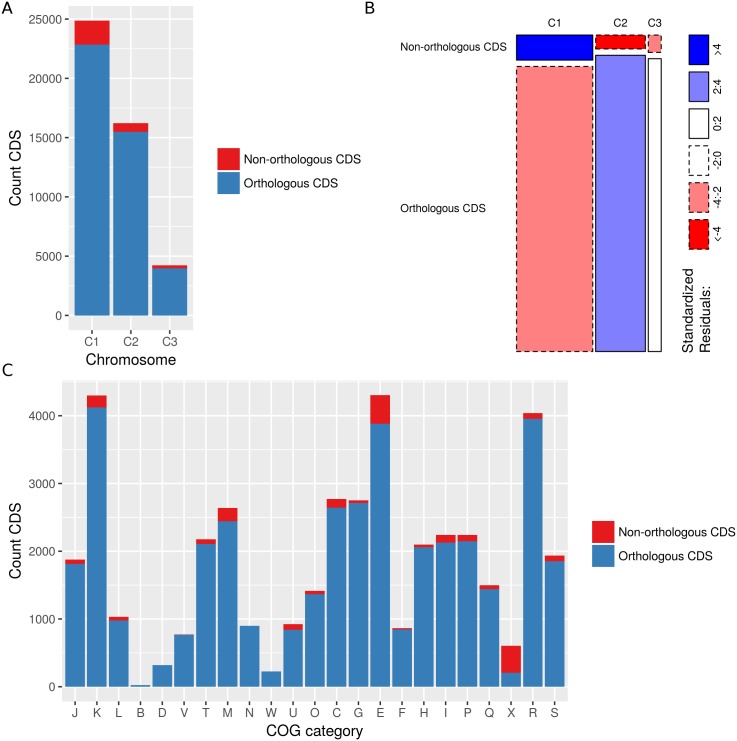
The frequency of orthologous versus non-orthologous CDS varies among chromosomes and COG categories.Bar plots show the number of orthologous and non-orthologous CDS per chromosome (X2(2) = 213.4, p<0.001) (a) and COG category (X2(22) = 5101.2, p<0.001) (c). Mosaic plots show the standardized residuals of the Pearson chi-square analysis for the number of orthologous and non-orthologous CDS per chromosome (b). Solid and dashed boundaries represent positive and negative residuals, respectively. Rectangles are colored only if the standardized residual is significant at p<0.05 (outside ±1.96). COG categories: J, translation, ribosomal structure and biogenesis; K, transcription; L, replication, recombination and repair; B, chromatin structure and dynamics; D, cell cycle control, cell division, chromosome partitioning; V, defense mechanisms; T, signal transduction mechanisms; M, cell wall/membrane/envelope biogenesis; N, cell motility; W, extracellular structures; U, intracellular trafficking, secretion, and vesicular transport; O, posttranslational modification, protein turnover, chaperones; X, mobilome: prophages, transposons; C, energy production and conversion; G, carbohydrate transport and metabolism; E, amino acid transport and metabolism; F, nucleotide transport and metabolism; H, coenzyme transport and metabolism; I, lipid transport and metabolism; P, inorganic ion transport and metabolism; Q, secondary metabolites biosynthesis, transport and catabolism; R, general function prediction only; S, function unknown.